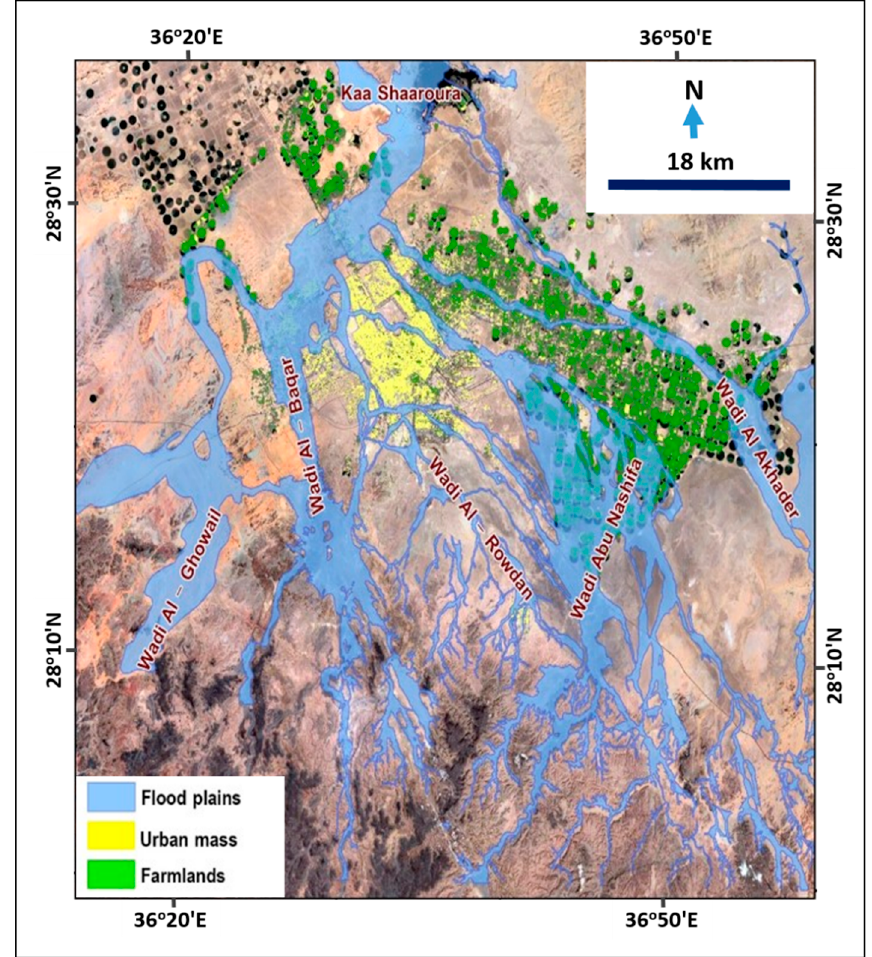
Figure 7. Inundation floodplain and its relationship to Tabuk urban areas in 2018.